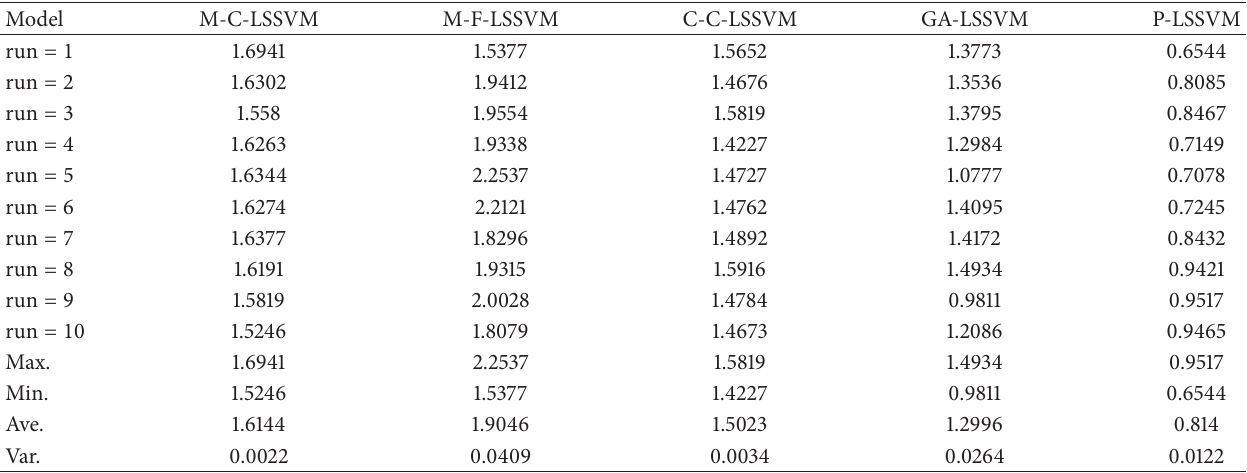
Table 4: Five models predicted error based on NMSE for FM broadcasting band.